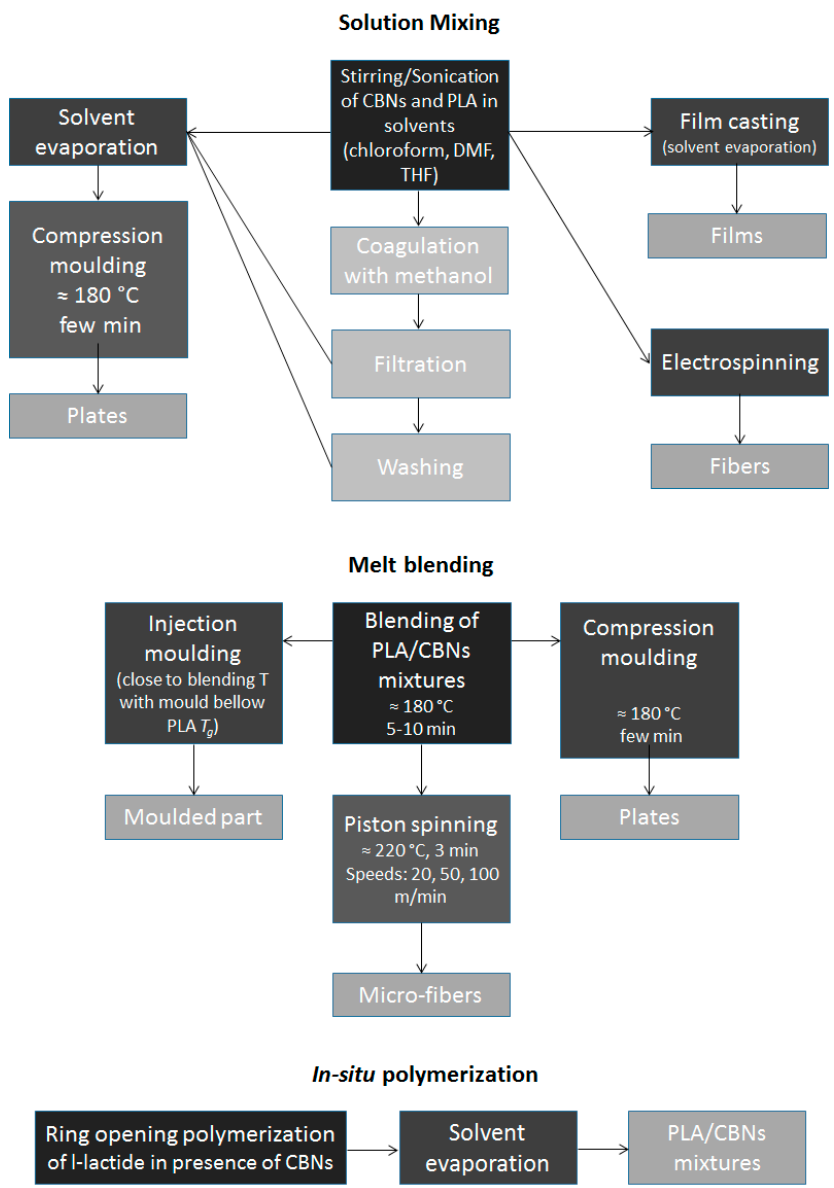
Figure 2. Scheme showing the different production methods of PLA/CBN composites.